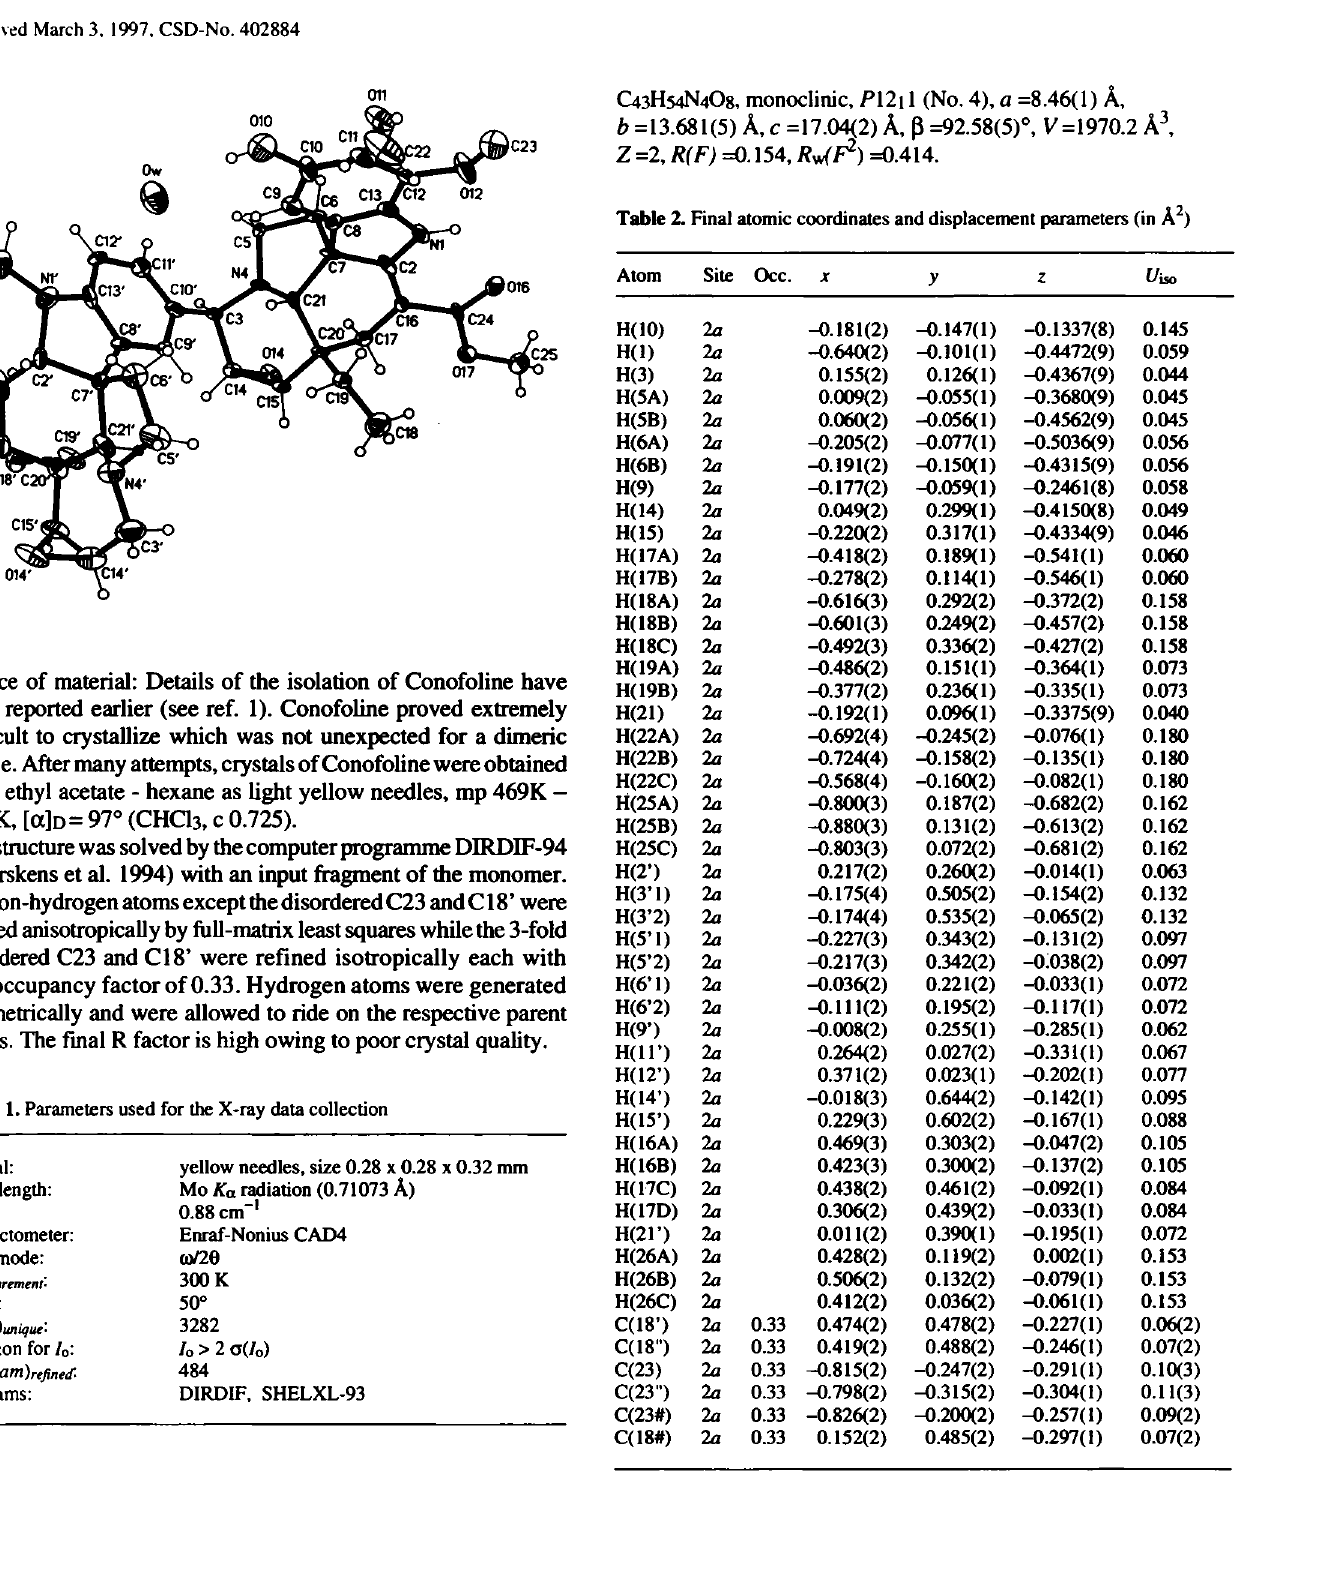
Table 2. Final atomic coordinates and displacement parameters (in Â^)